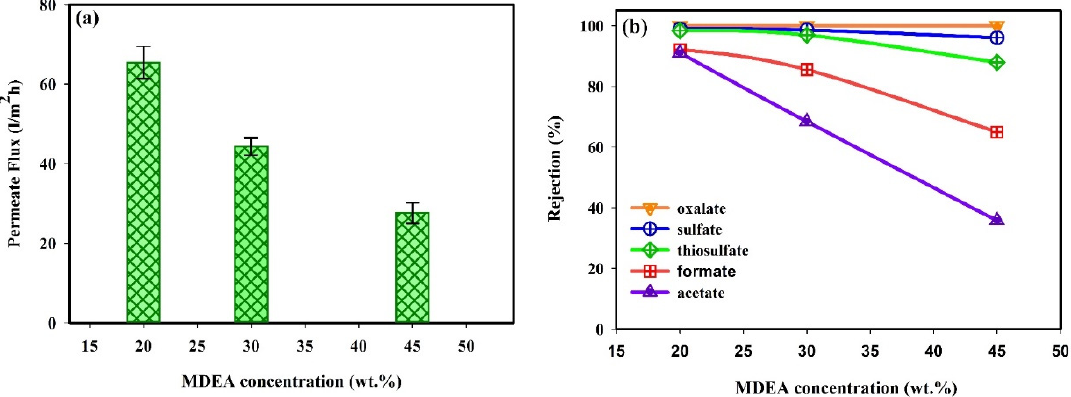
Figure 5. Effect of the MDEA concentration on ( a ) the permeate flux, and ( b ) the rejection of ions at the operation pressure 70 bar, 0.693 L/h, 35 °C and pH = 10.